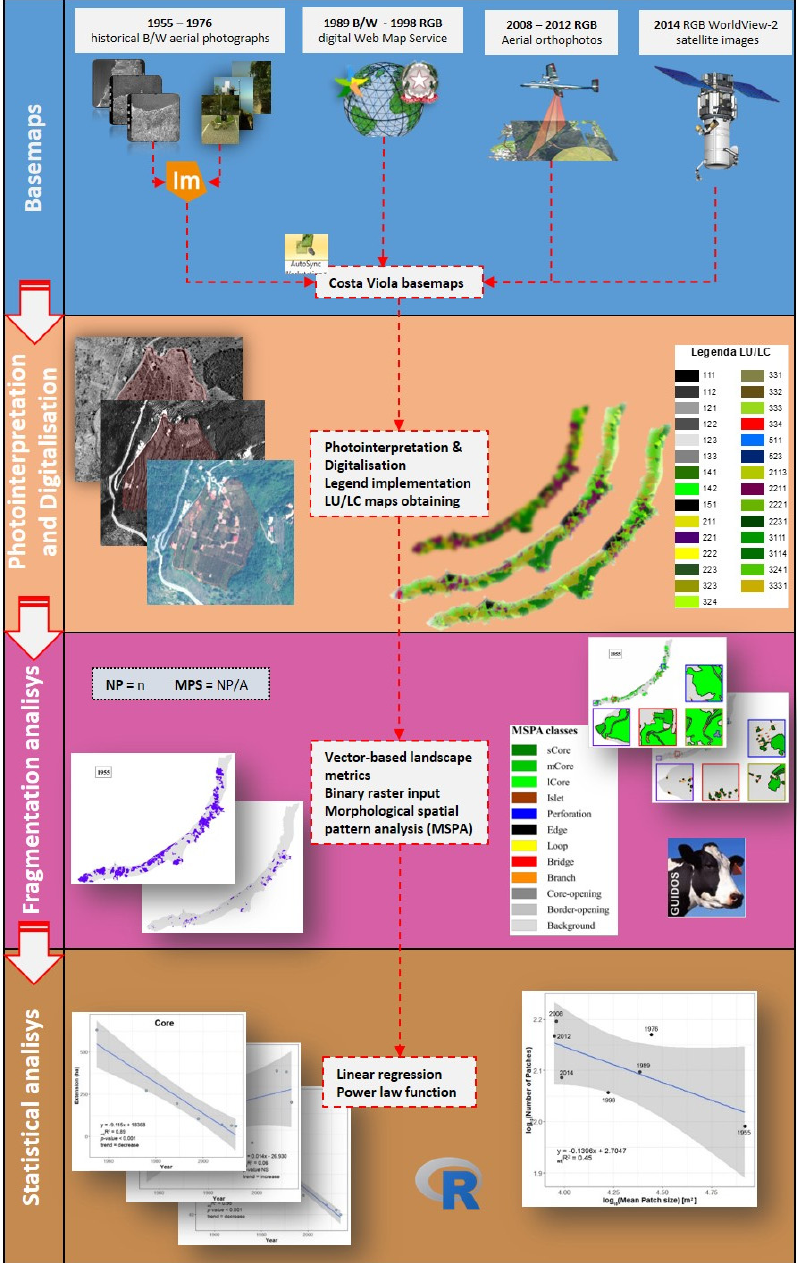
Figure 1. Workflow of the multitemporal approach applied to the Costa Viola terraced landscape.